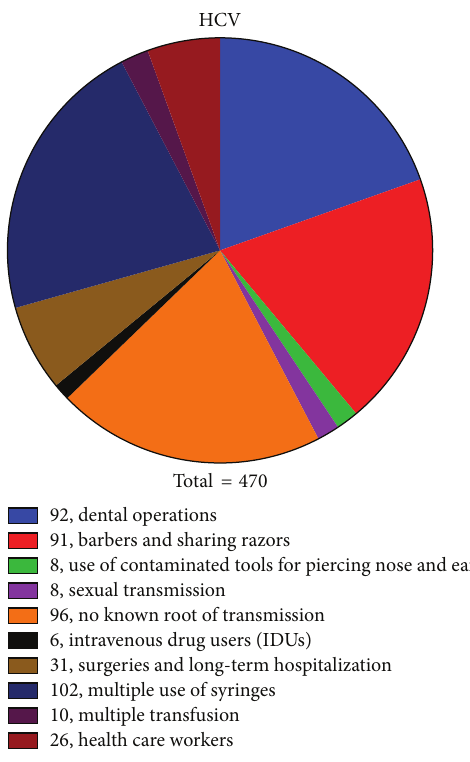
Figure 6: Risk factors associated with infection transmission in HCV single infection.